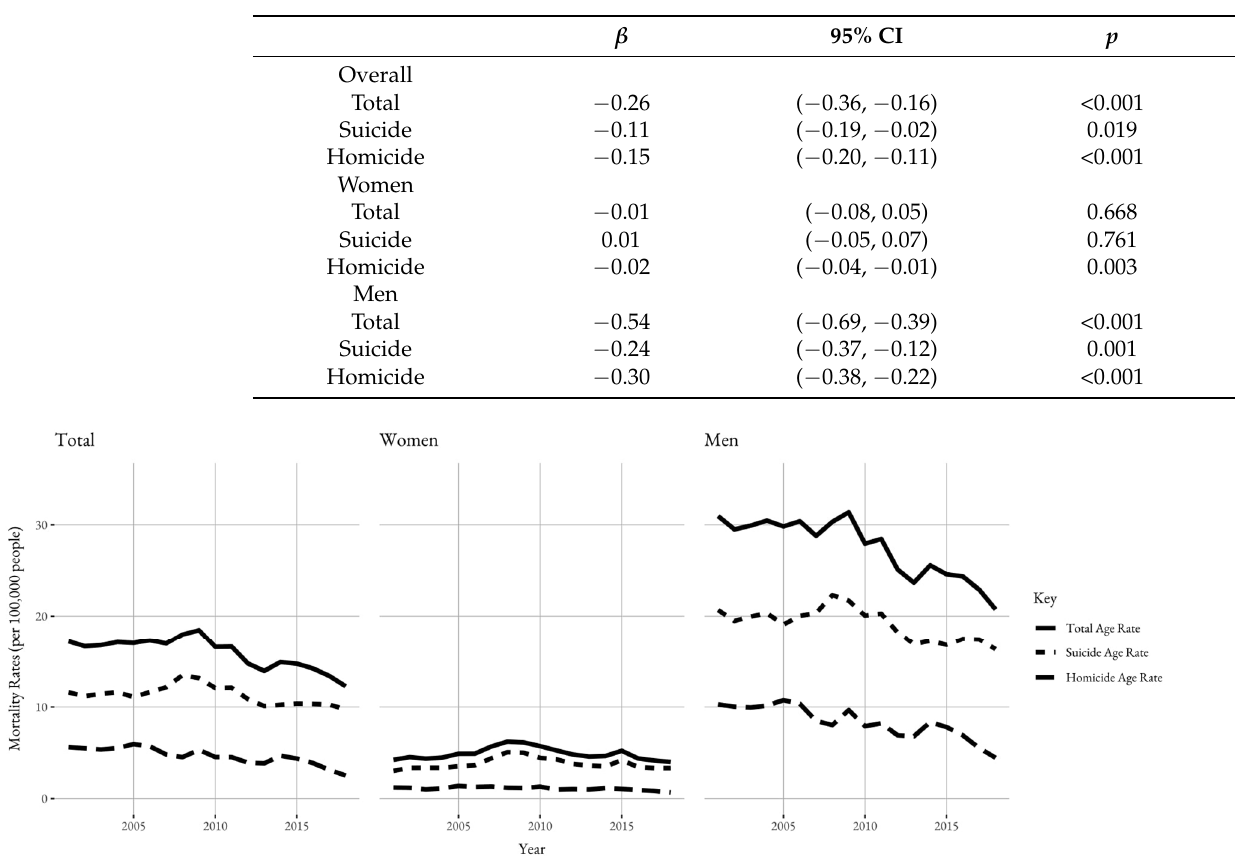
Table 2. Time trends for violent mortality rates by gender and intention, Chile, 2001–2018.